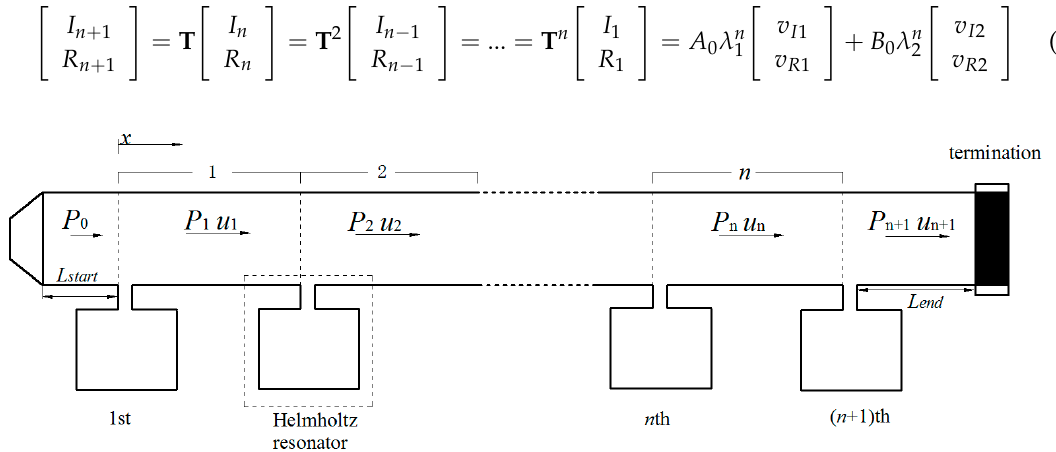
Figure 2. A periodic Helmholtz resonator array installed on the duct.